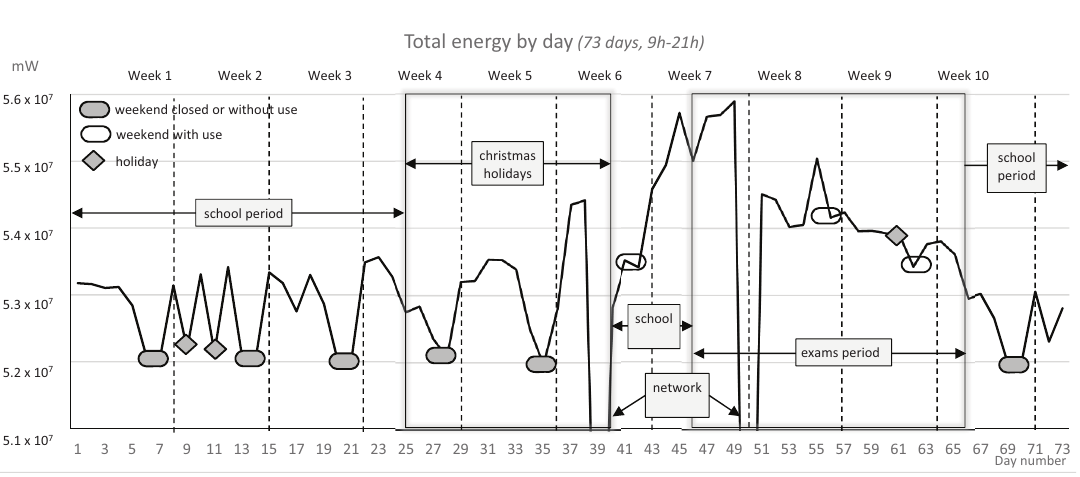
Figure 3. Daily evolution of the energy of the access points in the period, considering the time slot from 9:00 to